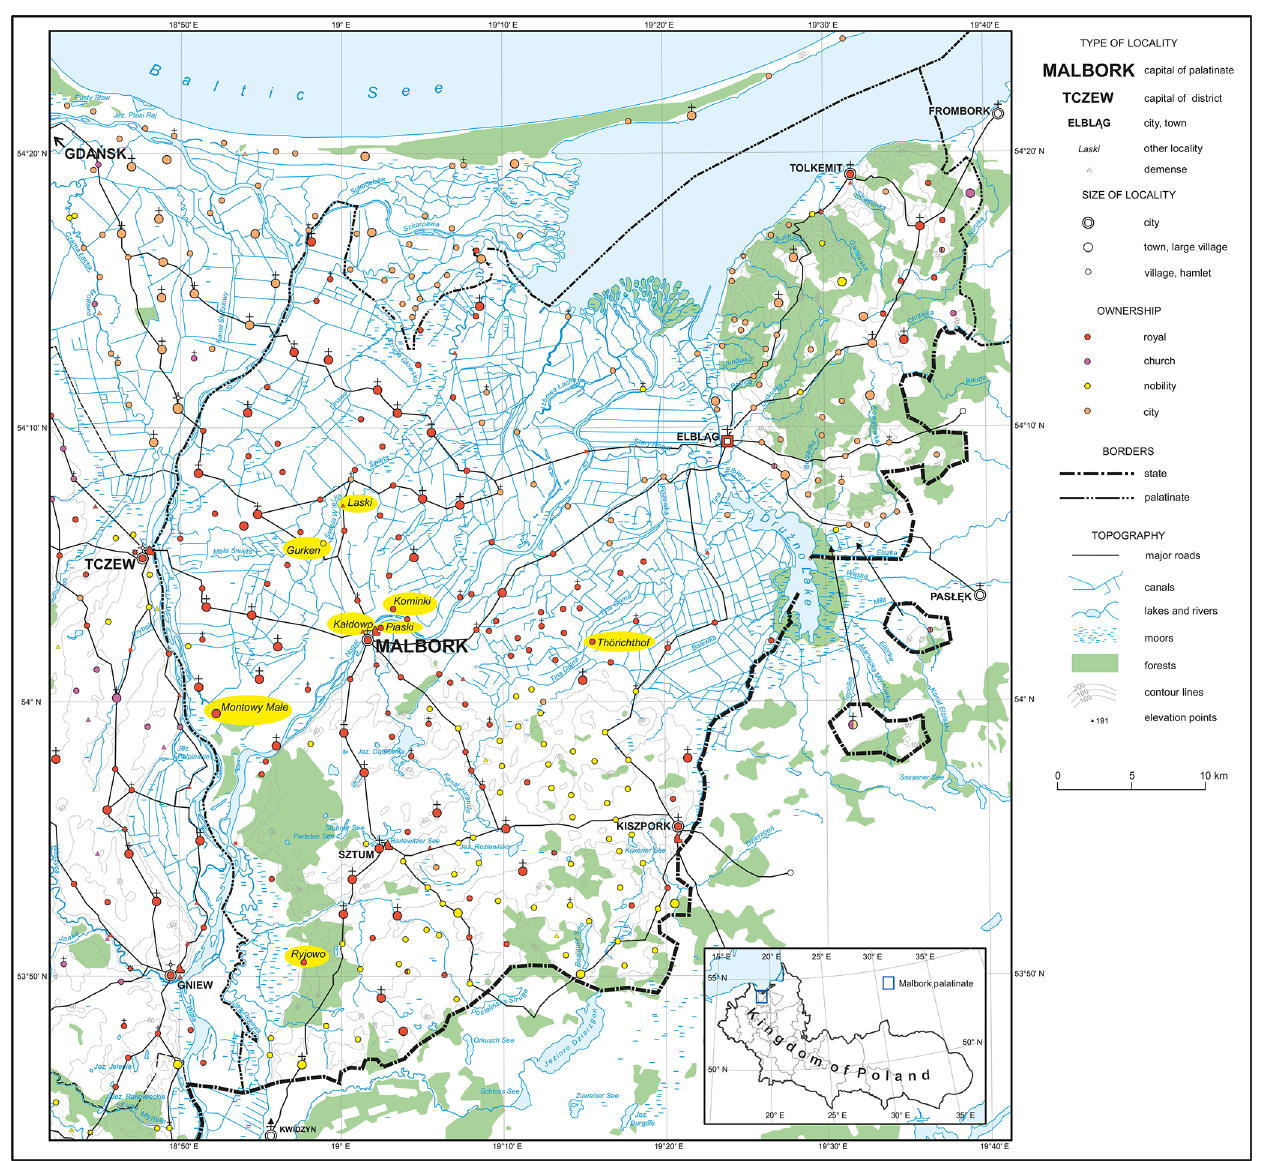
Figure 3. Vistula Fens settlement. Map made by Tomasz Panecki based on data collected while writing the article and files from https: //atlasfontium.pl/ website (last access: 24 June